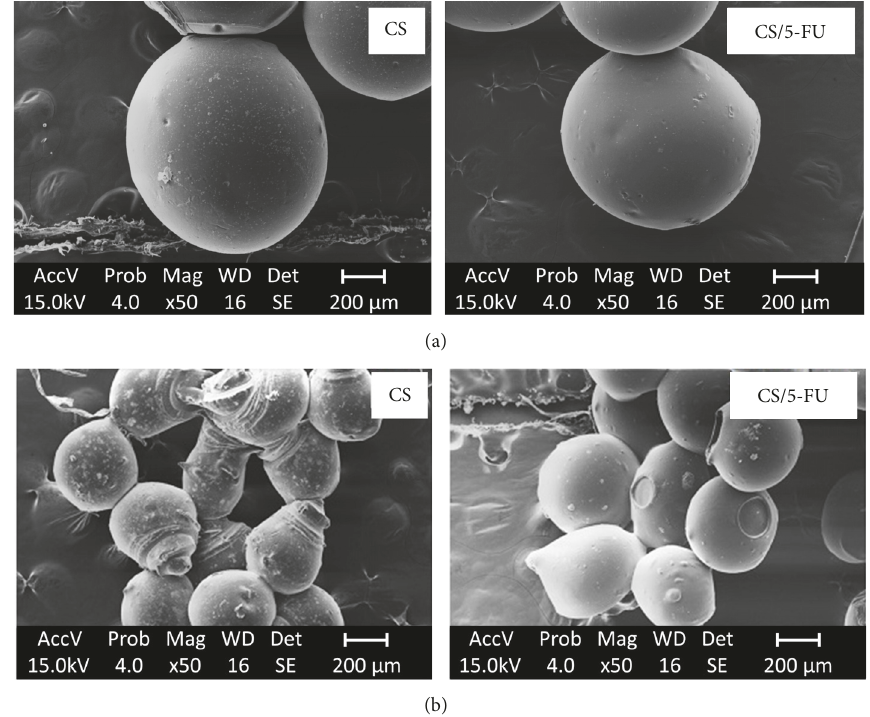
Figure 5: Microspheres prepared at 0.15 mL ⋅ min −1 injection flow rate (IR 1 ) and two airflow rates: (a) 2.5 L ⋅ min −1 and (b) 10.0 L ⋅ min −1 .